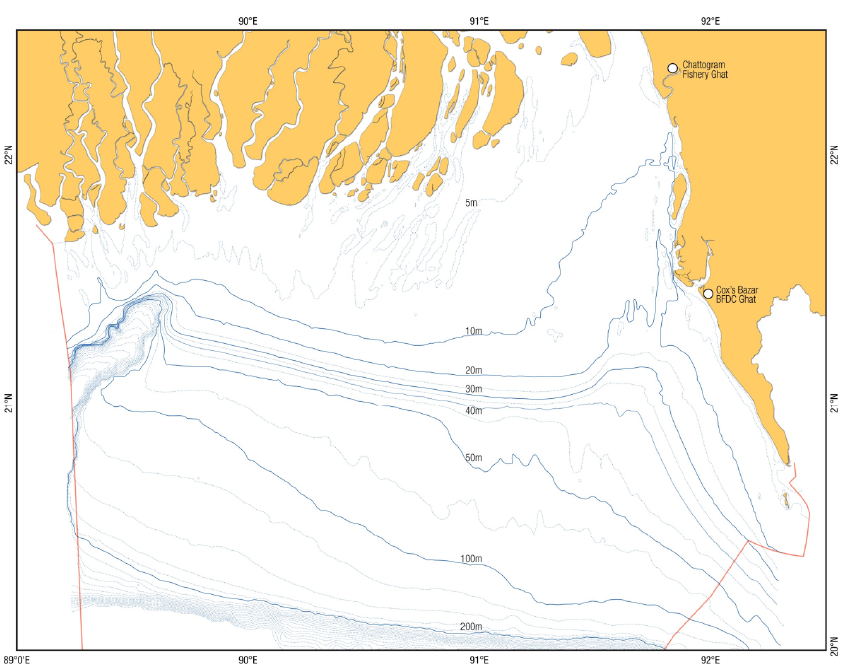
Figure 1. Bay of Bengal, Bangladesh coastal map showing the different depth zones within the fishing grounds.